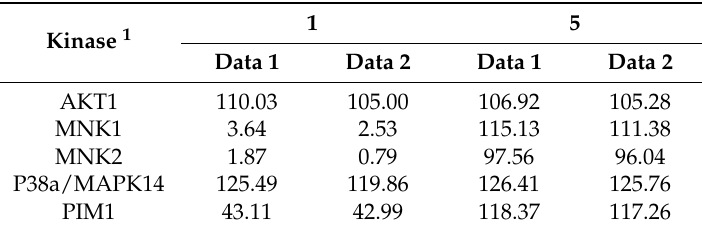
Table 2. Selectivity of compound 1 and 5 against a panel of kinases (% enzyme activity relative to DMSO